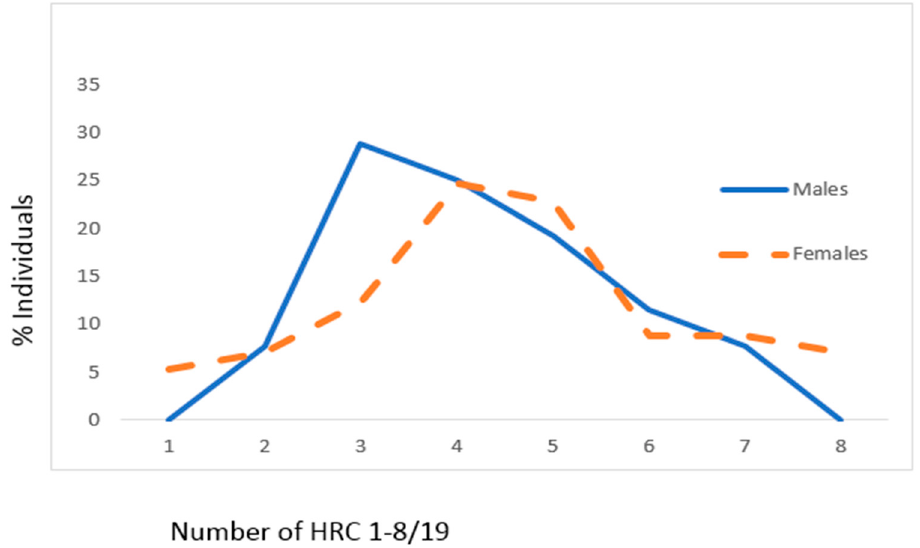
Figure 3. Frequencies of homozygous recessive characteristics (hrc) in males and females of the CAD sample with DM. X—mean values with standard deviation, V—variability, z—Mann Whitney U test. Males: n = 52, x hrc/19 = 4.21 ± 1.39 (95% CI 3.82–4.60). Females: n = 57, x hrc/19 = 4.67 ± 1.88 (95% CI 4.06–5.03; z = 1.401, p = 0.162). V Males = 33.02%, V Females = 40.26%.